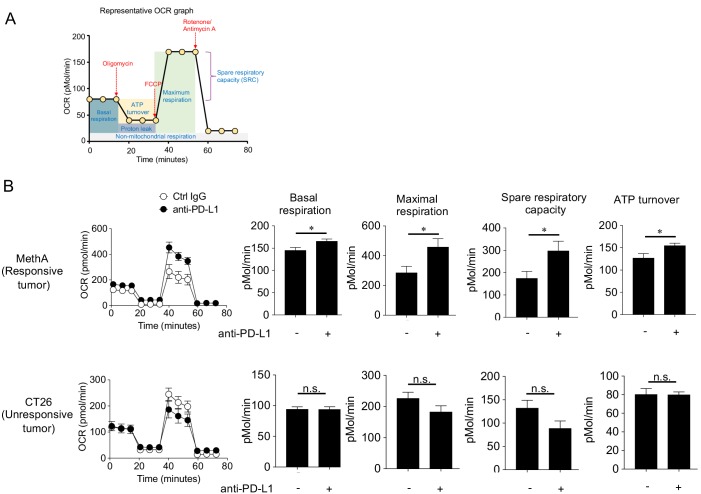
CD8+ T cells from mice with sensitive tumor have higher mitochondrial activity after PD-1 blockade than those with unresponsive tumors in BALB/c background.(A) Representative OCR plot by Seahorse XFe analyzer, showing basal respiration, maximal respiration, spare respiratory capacity, ATP turnover, proton-leak, and non-mitochondrial respiration, is shown. (B) OCR of DLN CD8+ T cells was measured from experimental groups of Figure 1—figure supplement 3. DLN CD8+ T cells were purified from the pooled cells of each group. OCR plot (left) and its associated parameters (right) from responsive tumor (top panels) and unresponsive tumor (bottom panels) are shown. Data represent the means ± SEM of five wells. *p < 0.05, two-tailed student’s t-test analysis. Data are representative of two independent experiments. n.s. represents ‘not significant’.